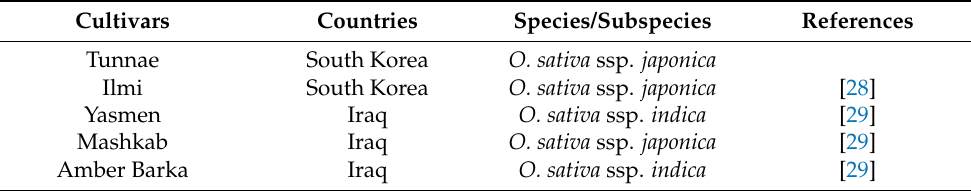
Table 1. List of rice